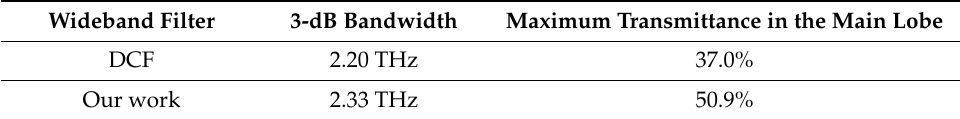
Table 2. Comparison of our work and double-cone filter (DCF) terahertz wideband